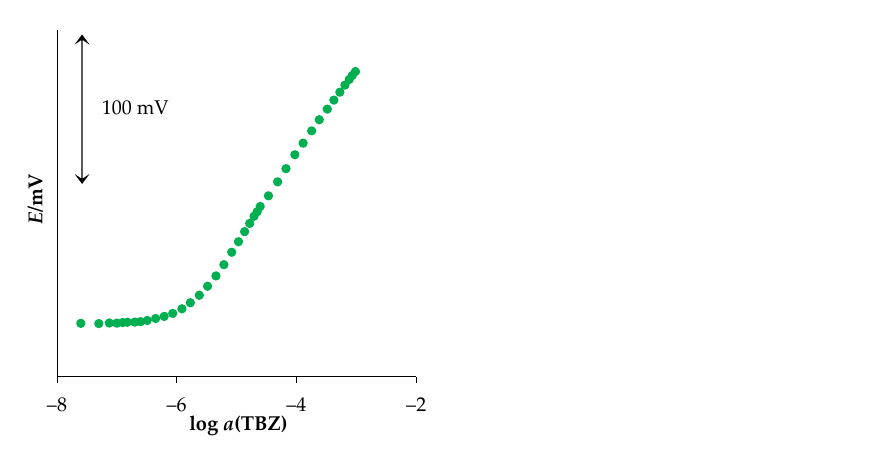
Figure 2. Response to thiabendazole (TBZ), obtained using the MWCNT-OSO 3 − TBZ + sensor. Table 1. Statistics of the response characteristics of the MWCNT-OSO 3 − TBZ + sensor to TBZ 1 .